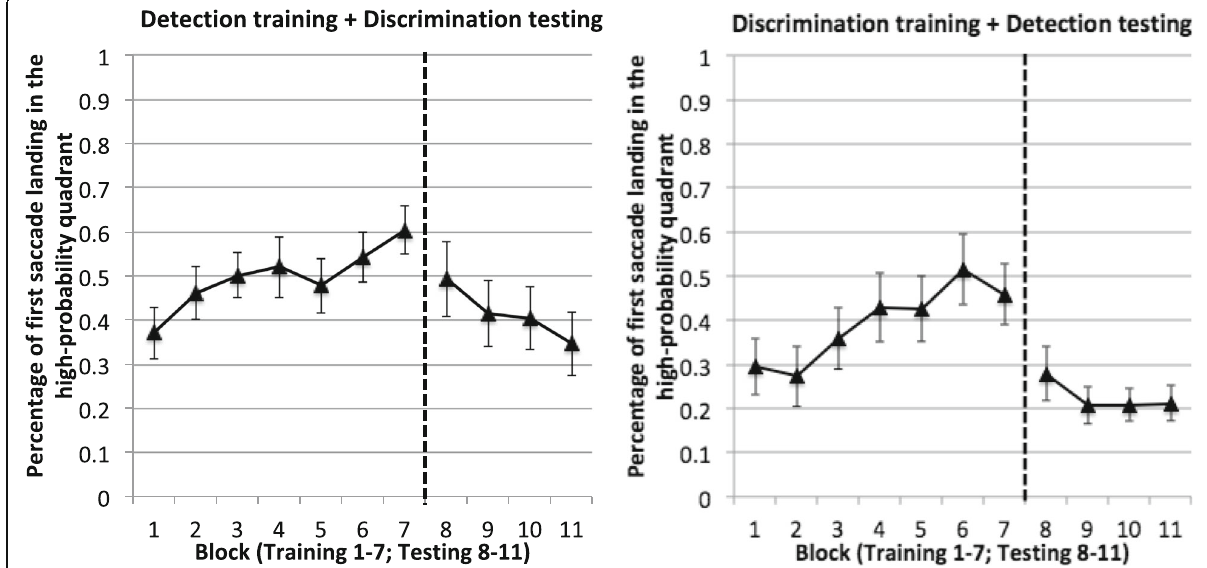
Fig. 6 Direction of the first saccadic eye movement in Experiment 2. Plotted are the percentage of trials where the first saccadic eye movement was directed toward the high-probability quadrant on target-absent trials. Higher values indicate a stronger saccadic bias toward the high-probability quadrant. Error bars show ±1S.E. of the